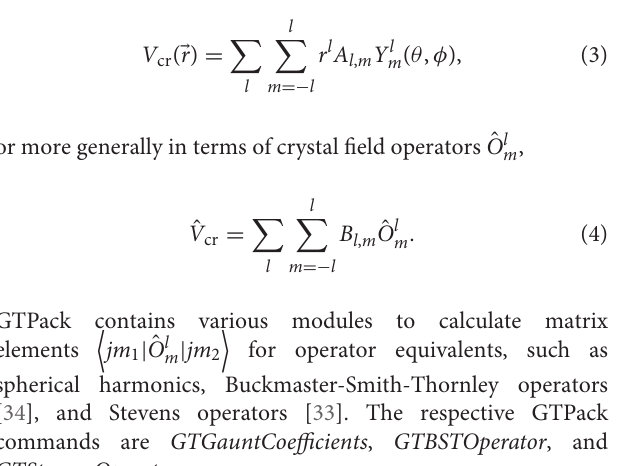
Frontiers in Physics |